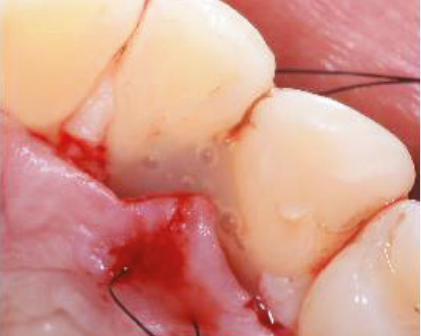
Figure 4: The re fl ection of the fl ap, including the papilla between 1.2 and 1.3, allowed a direct visualization of the intrabony defect and the radicular groove.